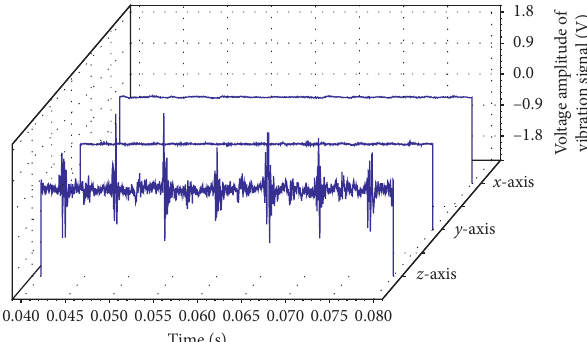
Figure 9: The time-domain waveform under the normal state.